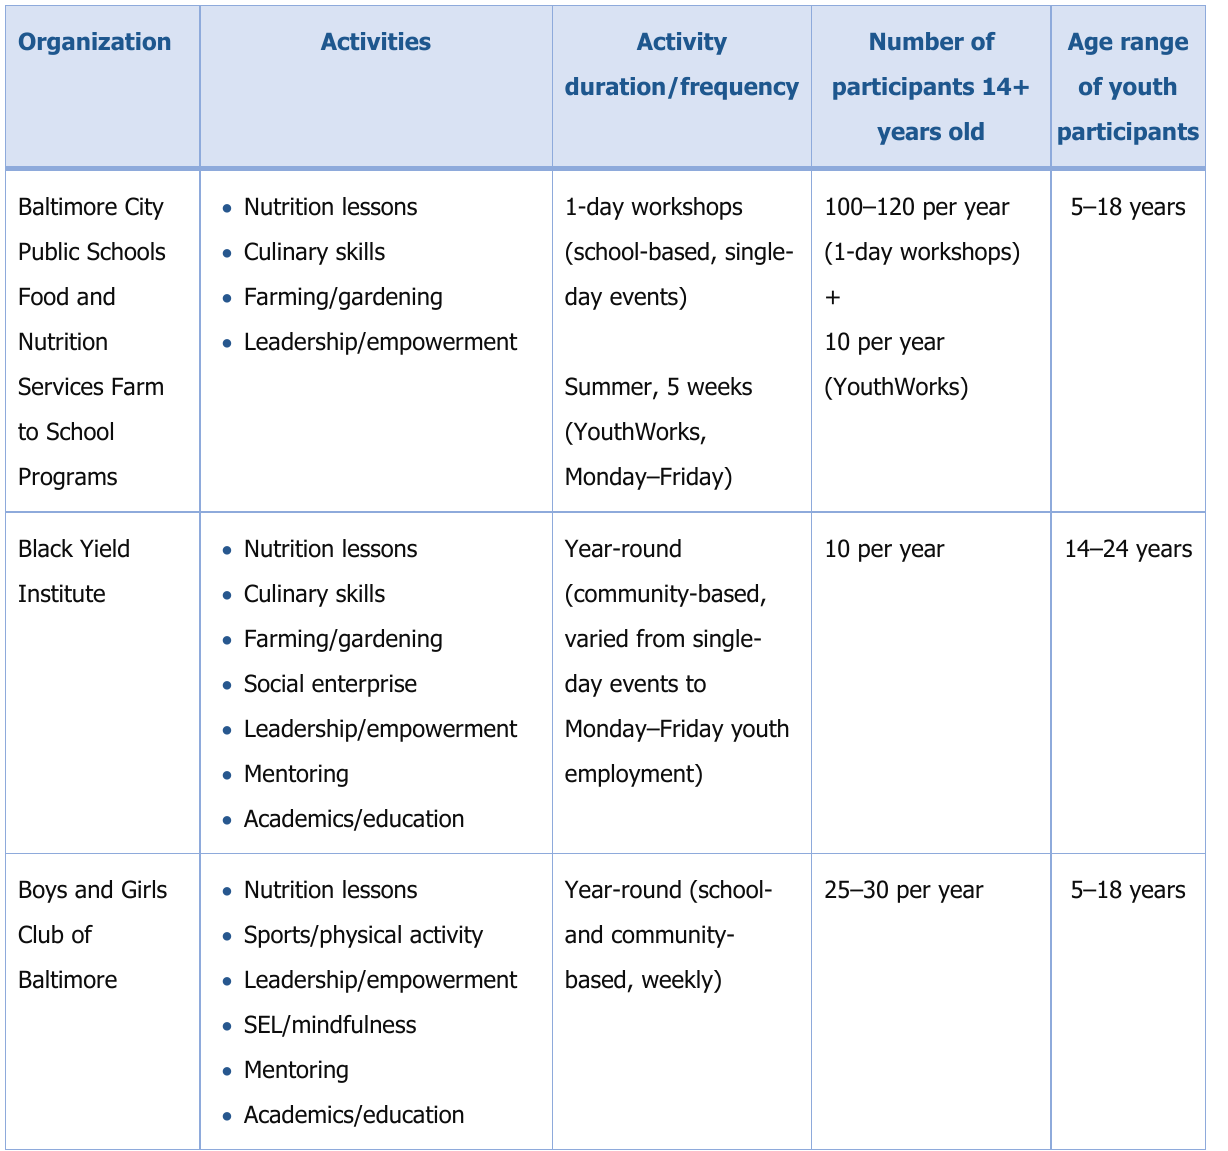
Table B1. Summary of Organizations and Characteristics of Youth-Facing Organizations in Baltimore City Included in The In-Depth